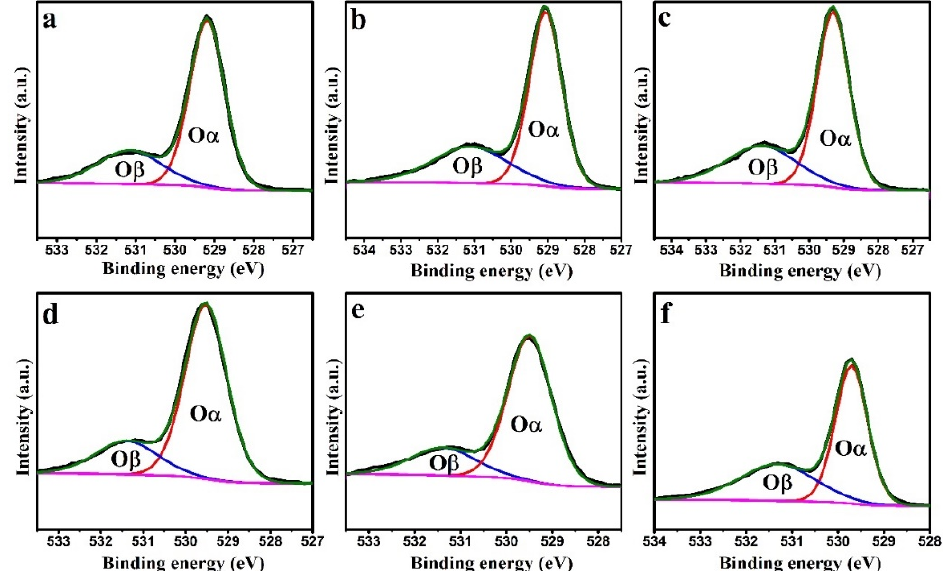
Figure 9. O1s XPS spectra of the CuO/CeO 2 catalysts: ( a ) CeO 2 , ( b ) 10%Cu/Ce, ( c ) 20%Cu/Ce, ( d ) 50%Cu/Ce, ( e ) 80%Cu/Ce, and ( f ) CuO. ( d ) 50%Cu/Ce, ( e ) 80%Cu/Ce, and ( f )